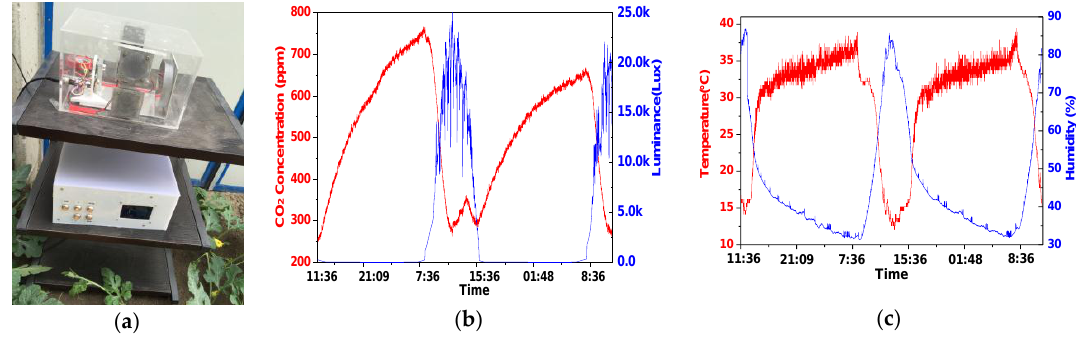
Figure 12. ( a ) The photo of a sensor node in a solar greenhouse; ( b ) The measured CO 2 concentration and luminance in a greenhouse; ( c ) The measured temperature and humidity in a greenhouse.